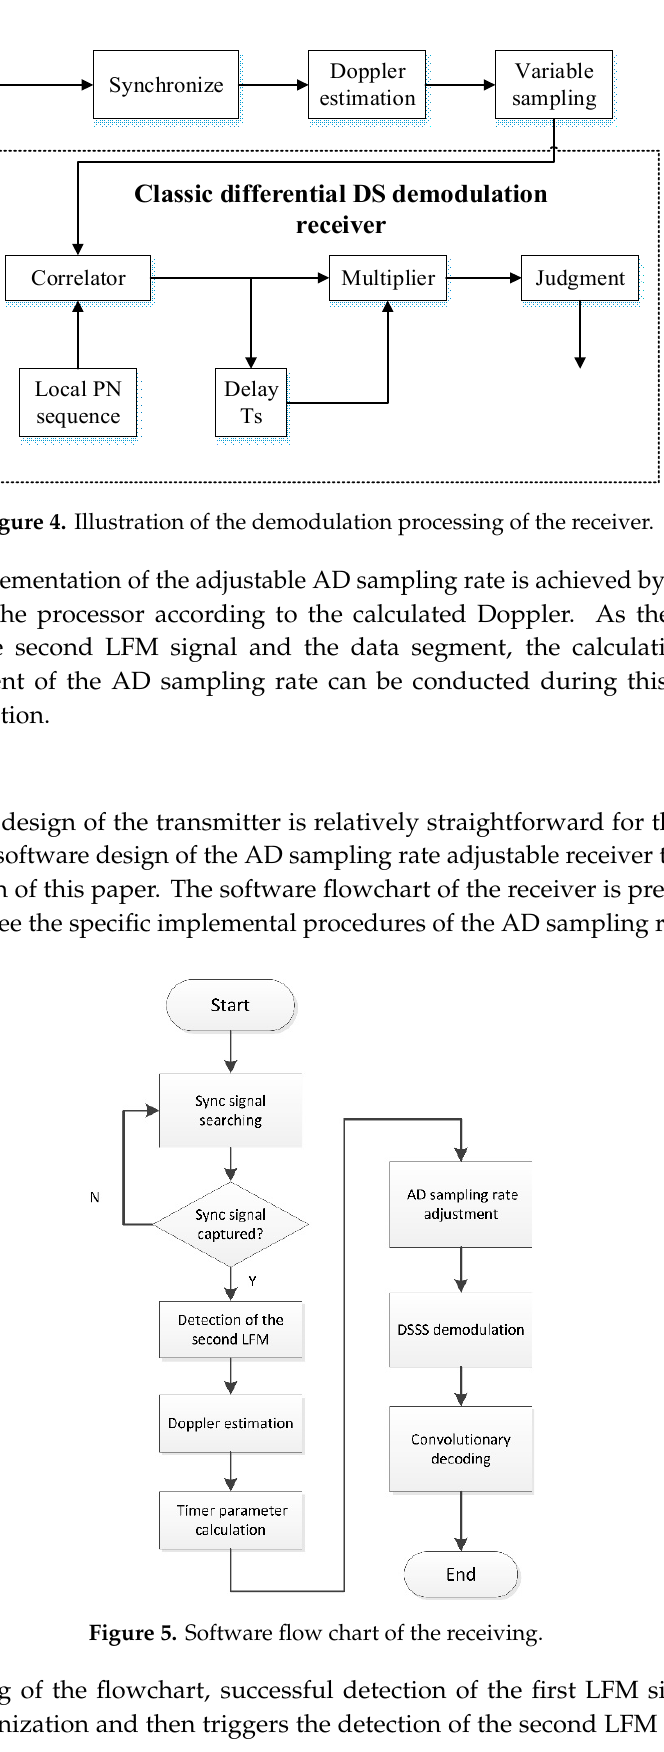
Figure 6. Block chart of the transmitter ( a ) and receiver ( b ). DAC=Digital-to-Analog Converter, ADC=Analog-to-Digital Converter.